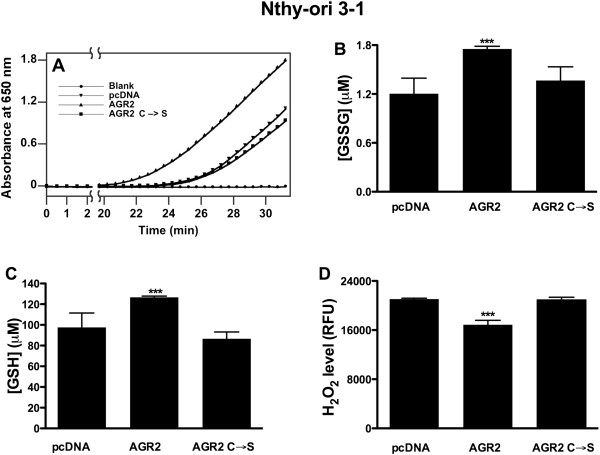
Disulfide isomerase activity of AGR2 and intracellular redox state. A) The disulfide isomerase activity of AGR2 was assayed with the insulin precipitation method. The absorbance at 650 nm was plotted against time (minutes). Only dithiothreitol was used as blank. B-C) Levels of GSSG and GSH in Nthy-ori 3–1 AGR2, AGR2 (C → S) and vector control cells were determined using GSH and GSSG assay kit. Values represent the average of duplicate experiments ± standard deviations. D) Nthy-ori 3–1 AGR2, AGR2 (C → S) and vector control cells were incubated H2DCFDA (100 μM) and levels of H2O2 were measured as described in Methods. Asterisks indicate P < 0.001 (***).